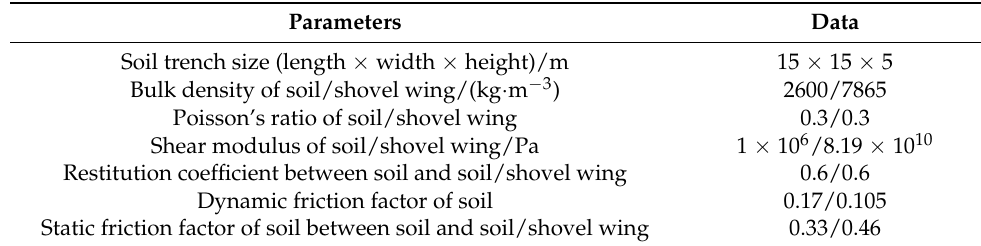
Table 1. Simulation model of soil contact parameters.